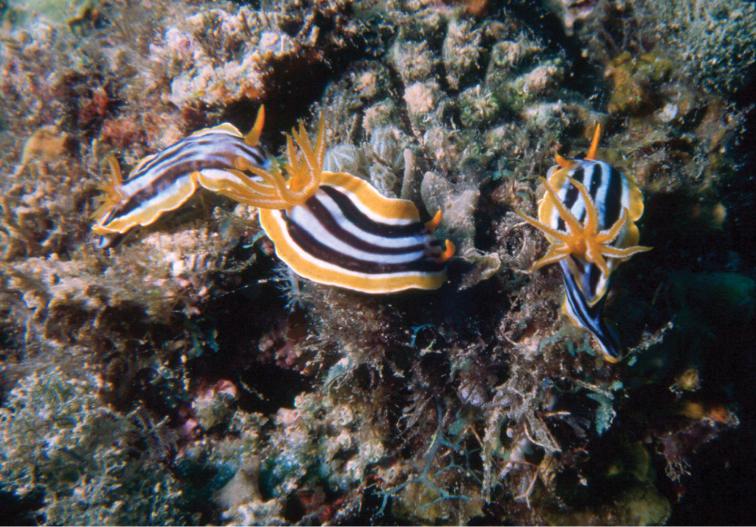

Chromodoris
quadricolor (Rüppell & Leuckart, 1830), photograph E Pridgen.